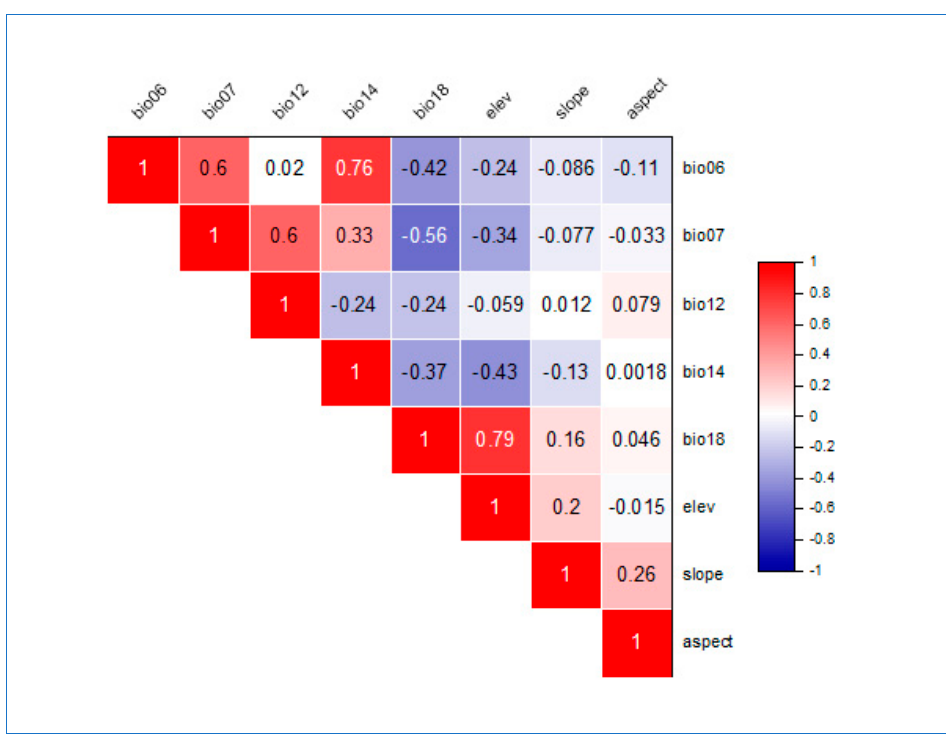
Figure 2. Pearson correlation heat map showing the pairwise correlation of climatic and biophysical variables (threshold; r = ±0.8) used in the distribution modeling of Himalayan goral.